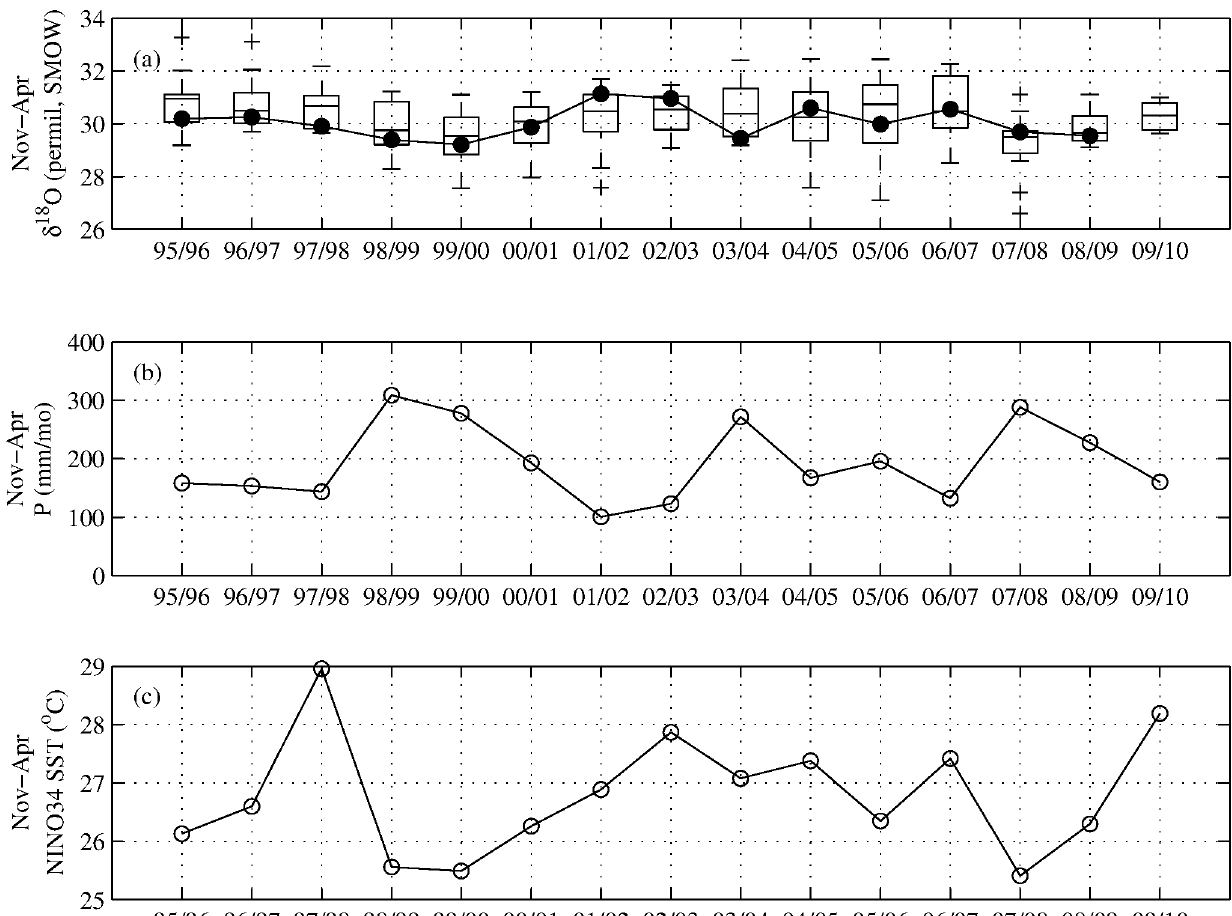
Figure 2. Observed composite d 18 O record from the Atherton Tablelands compared to local precipitation and NINO34 SST index. (a): Box-whisker plots (as described for Fig 1) show the distribution of values for each sample of 12 observations (4 interpolated values per season from each of three trees) in each growing season composite. Calendar age assignments (x-axis) are from the crossdating of the retained dendrochronological subset of tree cores from Dinden National Park (Table 2). Solid circles are process-modeled d 18 O estimates (see text for details.) (b) November–April average composite precipitation record from Tinaroo Falls and Kairi Research Station (Fig 1). (c) November–April average NINO34 SST.